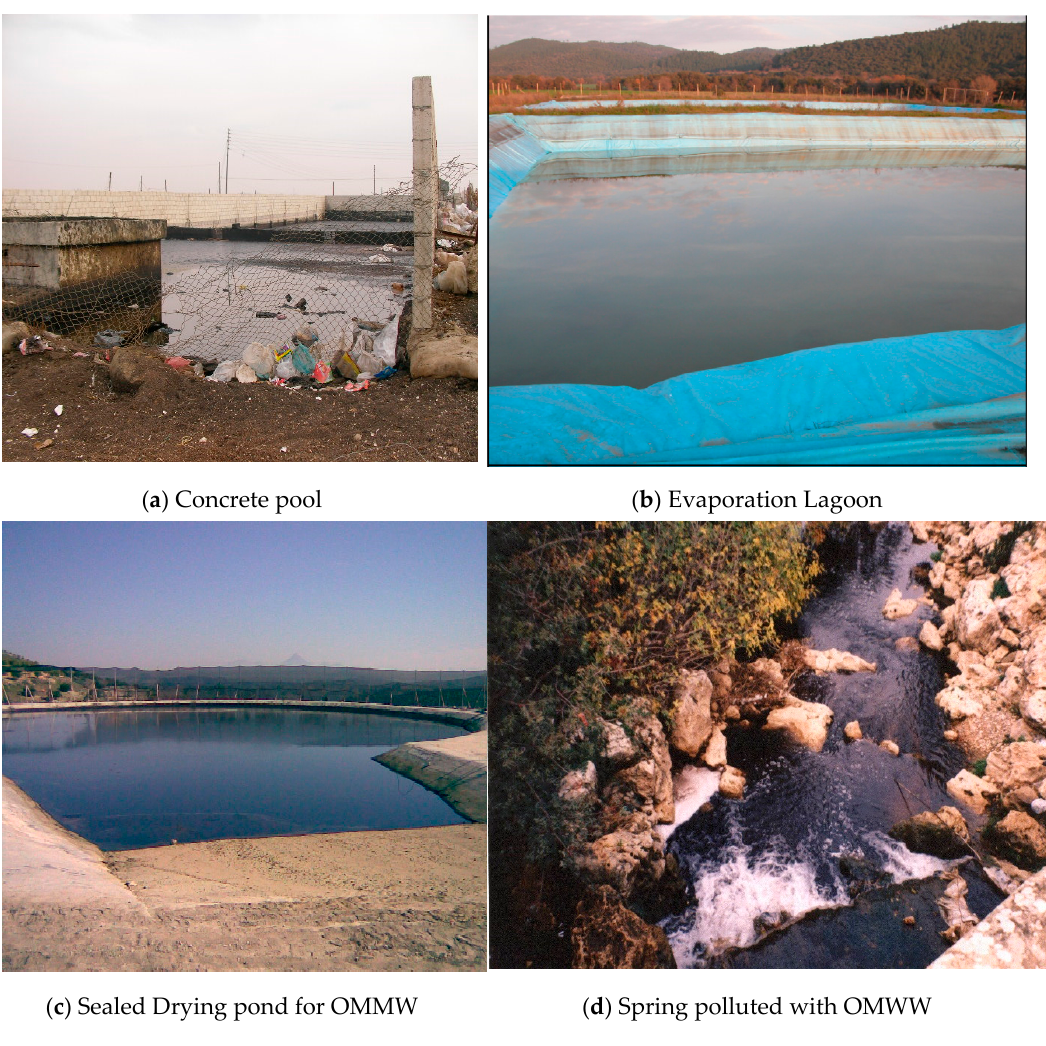
Figure 2. Wastewater storage and handling at different locations of olive mills in Irbid area.